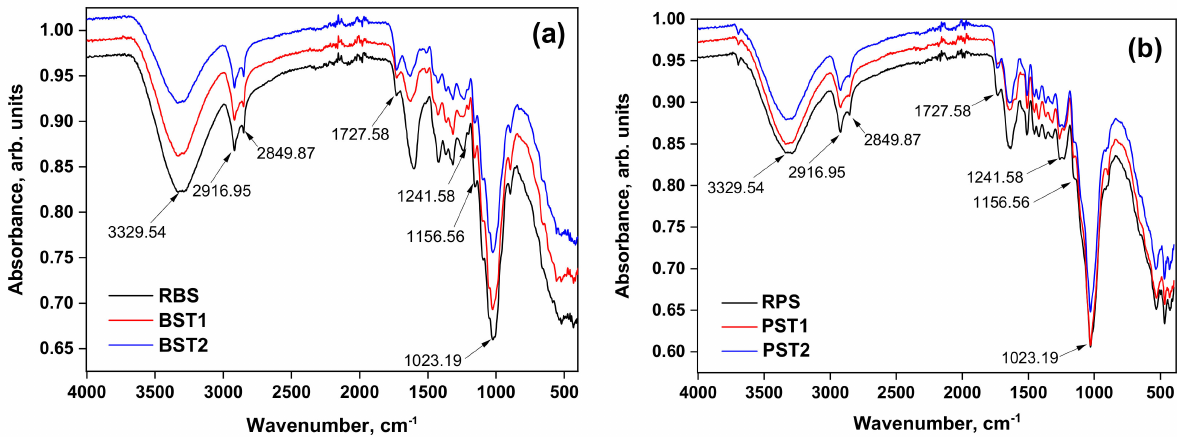
Figure 3. FTIR spectra of bean pods ( a ) and pistachio pods ( b ): RBS and RPS (black curve), BST1 and PST1 (red curve) and BST2 and PST2 (blue